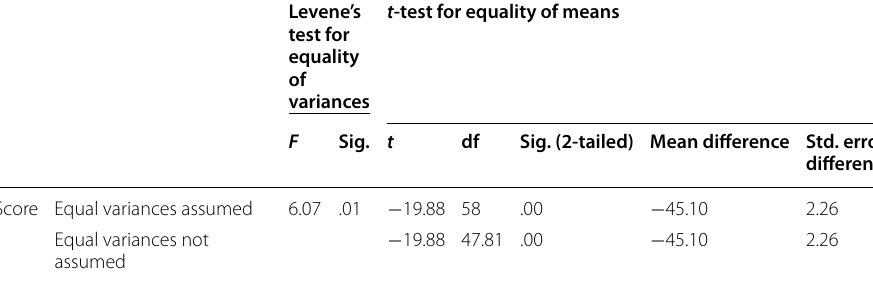
Table 25 Paired samples test (self‑efficacy pre‑ and post‑tests of each group) Mean Std. deviation Std. error mean t df Sig. (2-tailed) Pair 1 CG. Pre CG. Post 7.66 .00 − − Pair 2 EG. Pre EG. Post − −